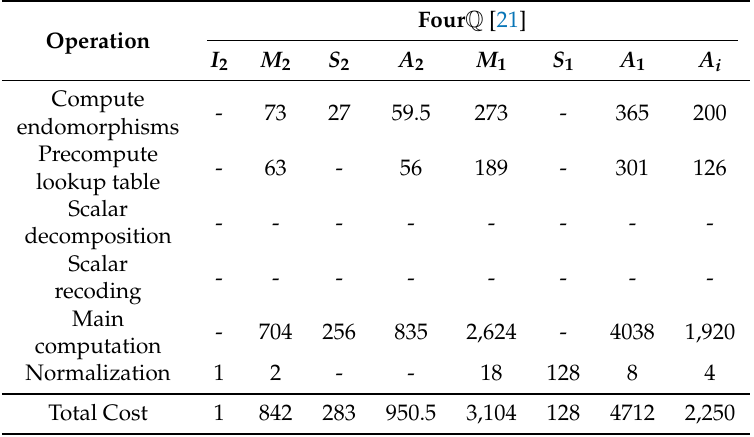
Table 2. The operation counts of curve Four Q using field arithmetic over F p 2 and operation counts for conversion into field arithmetic over F p